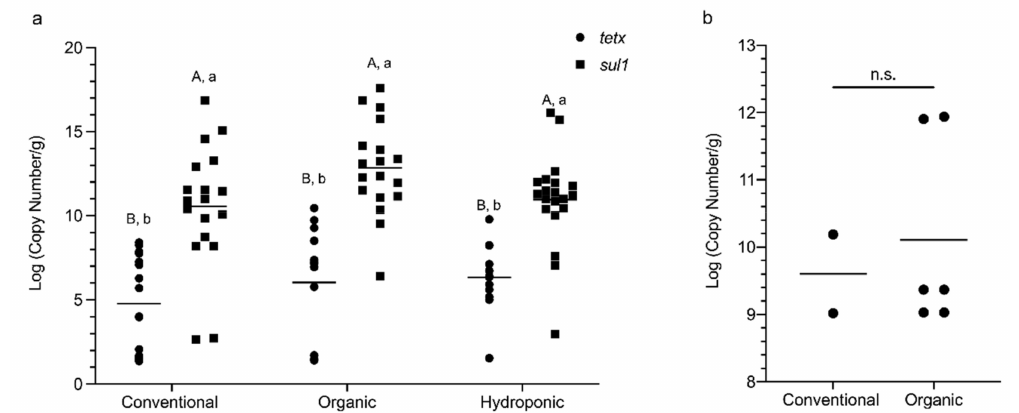
Figure 3. Copy numbers of tetX , sul1 , and int1 in lettuce samples: ( a ) comparison of the copy number of tetX and sul1 between lettuce of the three production methods by two-way ANOVA with Sidak’s test. Uppercase letters denote comparison between lettuce of the three production methods and lowercase letters denote comparison between the two resistance genes. Di ff erent letters indicate a significant di ff erence ( p < 0.05); ( b ) comparison of the copy number of int1 between the conventional and